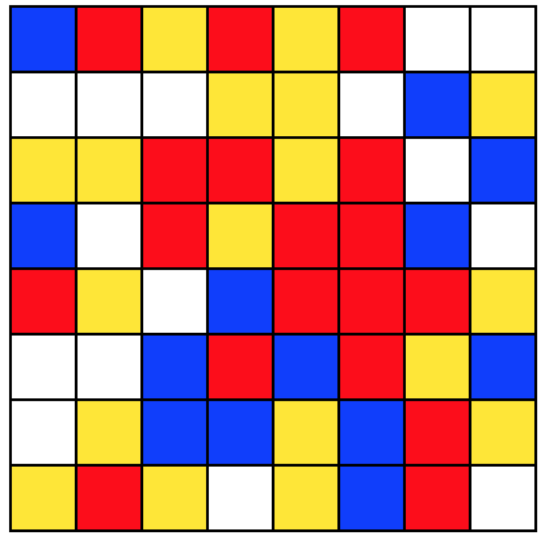
Figure 5. An example four-colour, 8 × 8 grid depicting a 128-bit binary value; in which the colour of each cell corresponds to the the value of two-bits in the